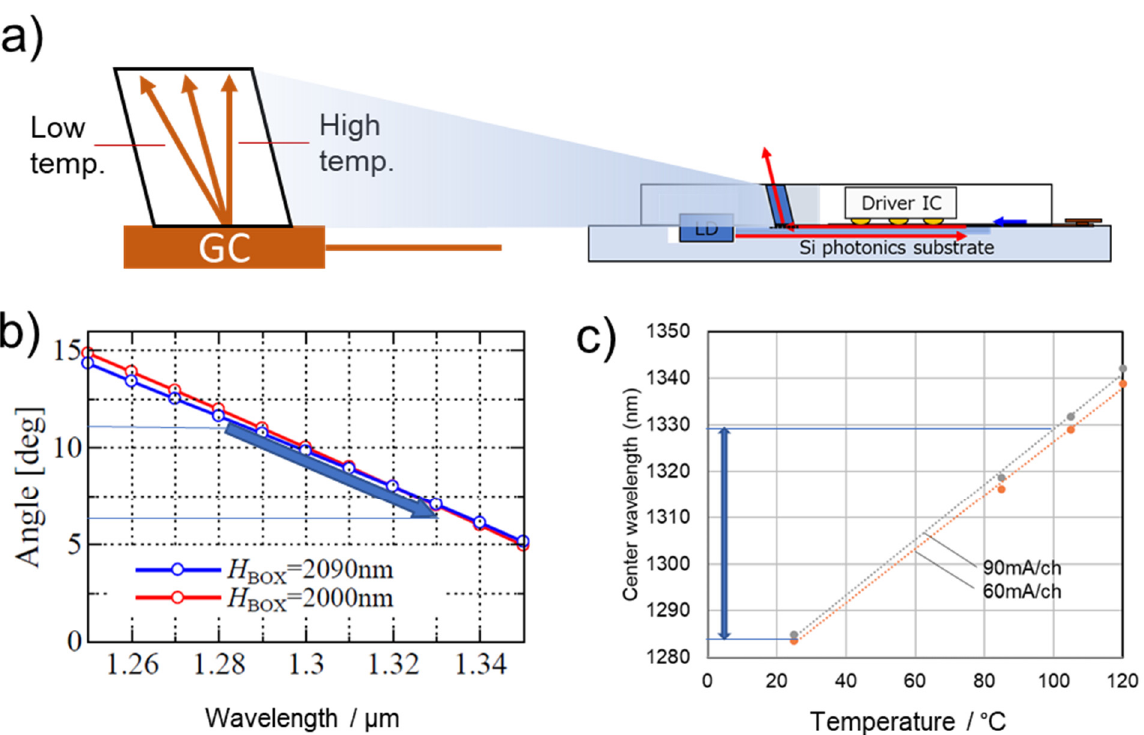
Figure 15. Optical coupling interface performance over temperature. ( a ) Schematic view of optical pin on Tx side accommodating variation in directional angle from the grating coupler over temperature; ( b ) variation of angle with wavelength; ( c ) variation of wavelength with temperature .